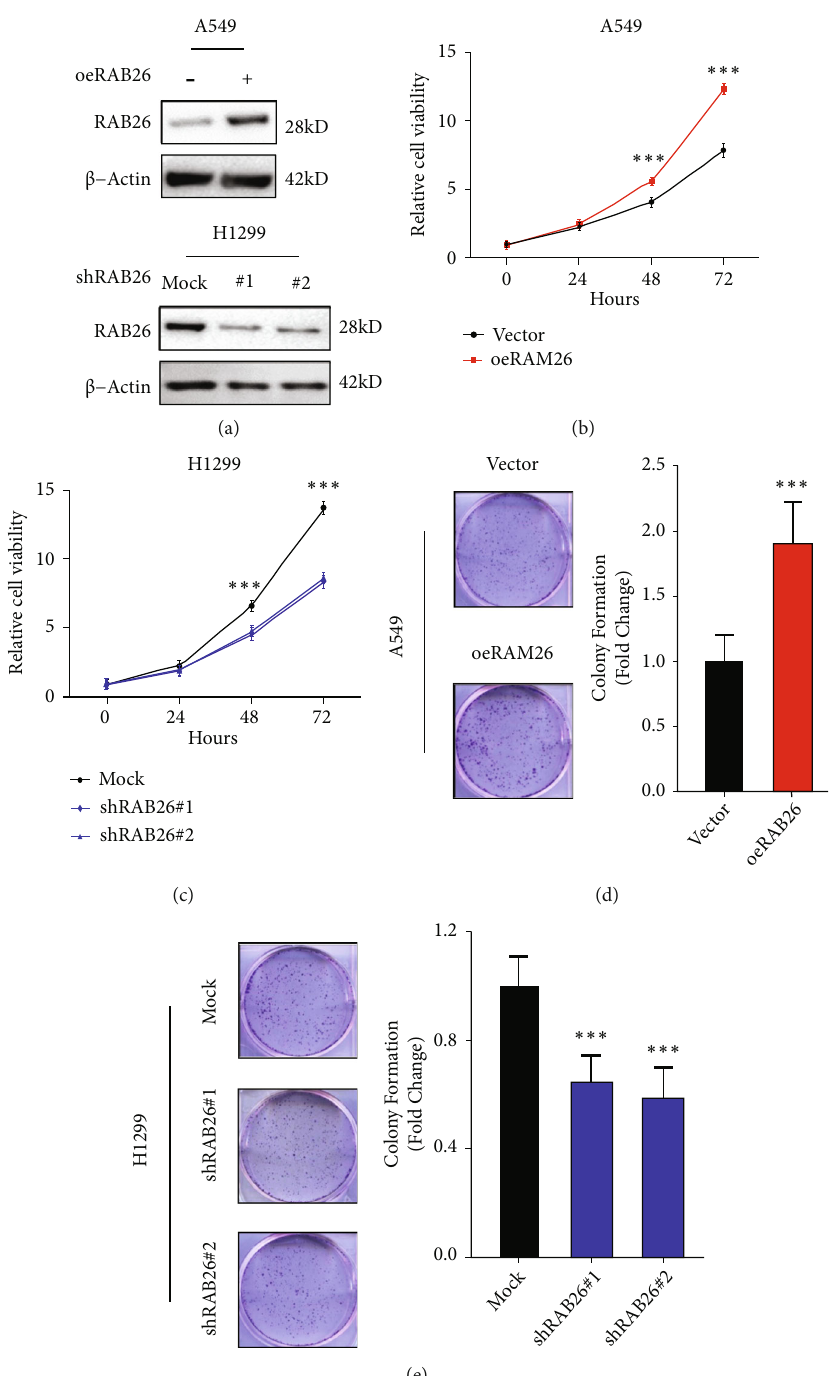
Figure 9: RAB26 promoted LUAD cell proliferation. (a) Western blot was performed to con fi rm the overexpression of RAB26 in A549 cells (top) and its knockdown in H1299 cells (bottom). (b, c) Cell proliferation assay of RAB26 -overexpressing A549 cells, RAB26 -knockdown H1299 cells and corresponding normal control cells. (d, e) Colony formation assay validated the promoting e ff ect of RAB26 on the proliferation of H1299 and A549 cells. The asterisks represent the statistical p -value ( ∗ p < 0 : 05 ; ∗∗ p < 0 : 01 ; ∗∗∗ p < 0 : 001